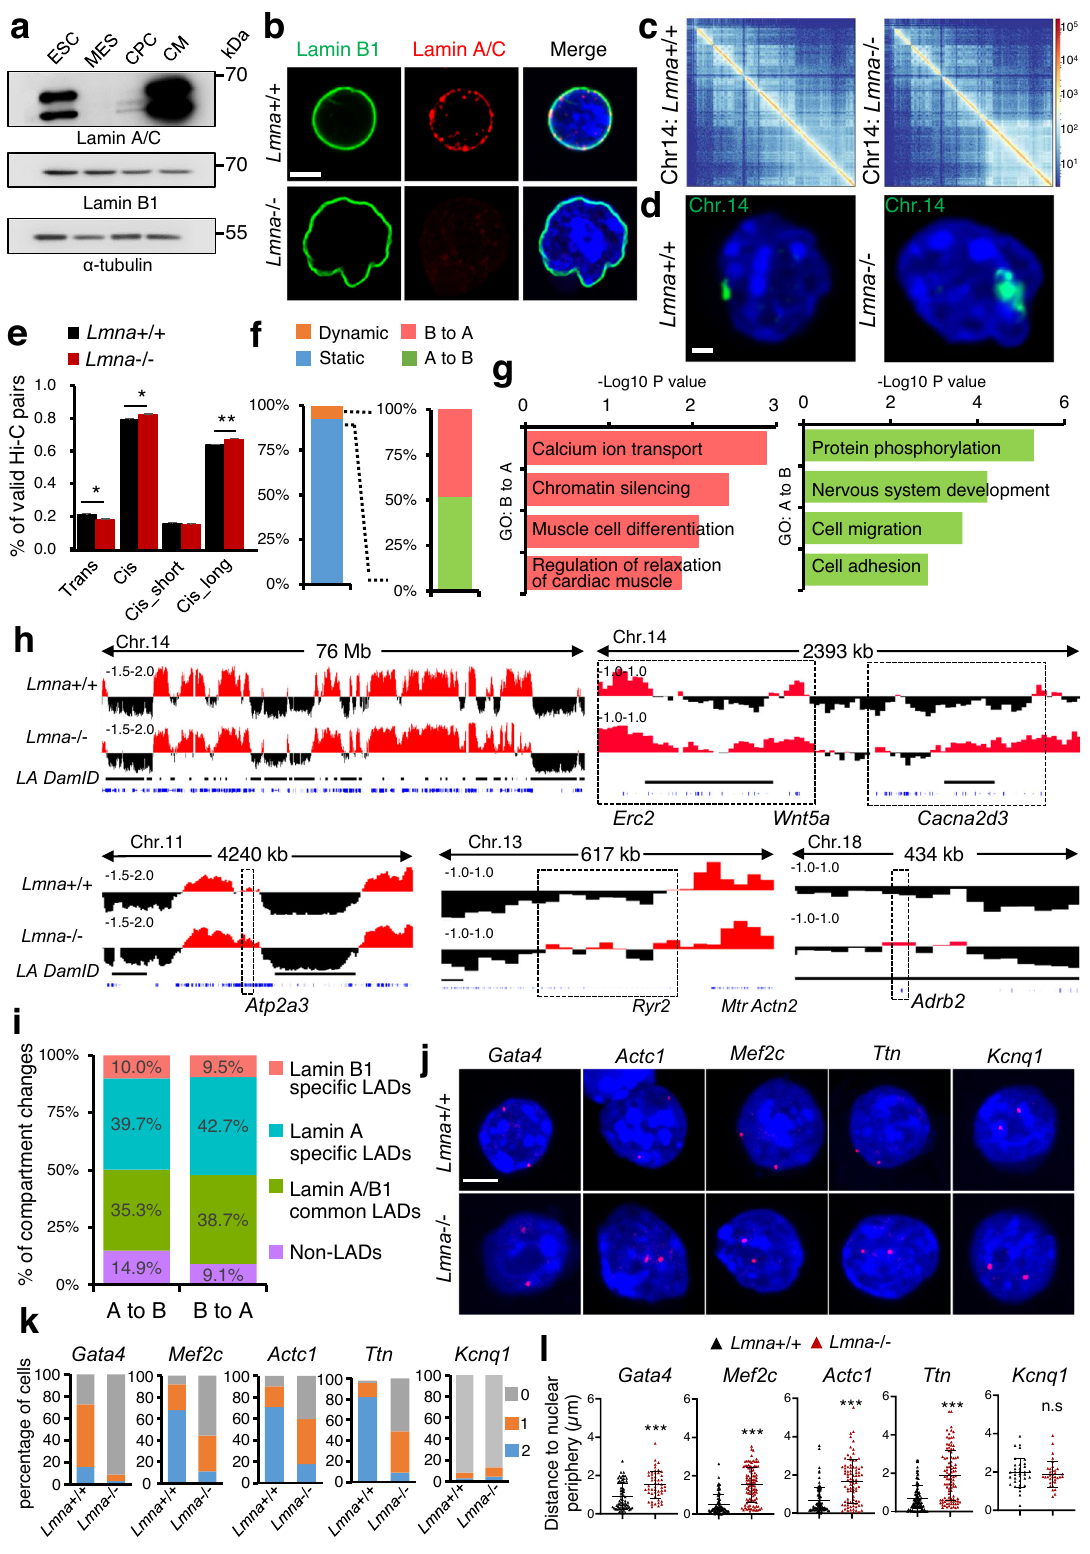
ESCs, CPs or CMs (Fig. 3i, clusters B-G). Intersection of the ATAC-Seq and RNA-Seq analysis revealed that more than half of the genes upregulated upon lamin A/C loss in ESCs showed increased chromatin accessibility (Fig. 3j) and GO analysis of the overlapping genes indi- cated overrepresentation of GO terms linked to transcription, cell differentiation, out fl ow tract morphogenesis as well as Wnt signaling